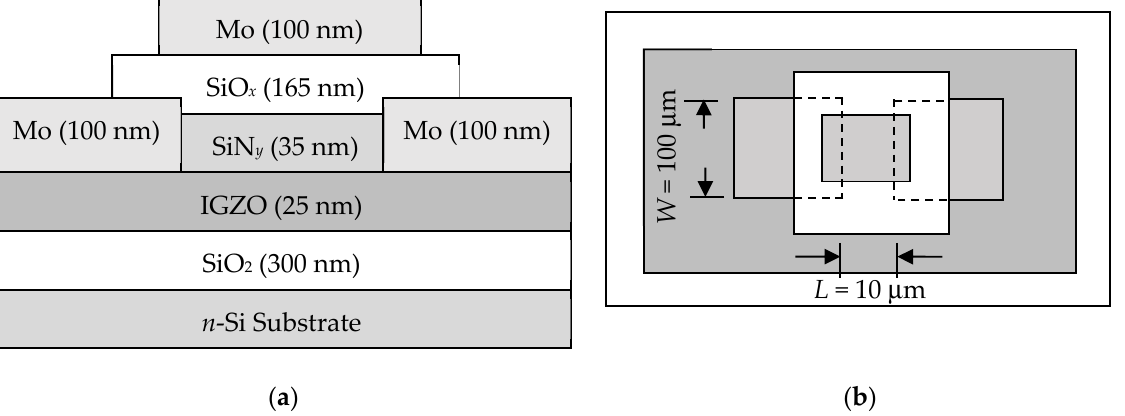
Figure 1. ( a ) Cross-sectional and ( b ) top-view device structures of the a -IGZO TFT samples.